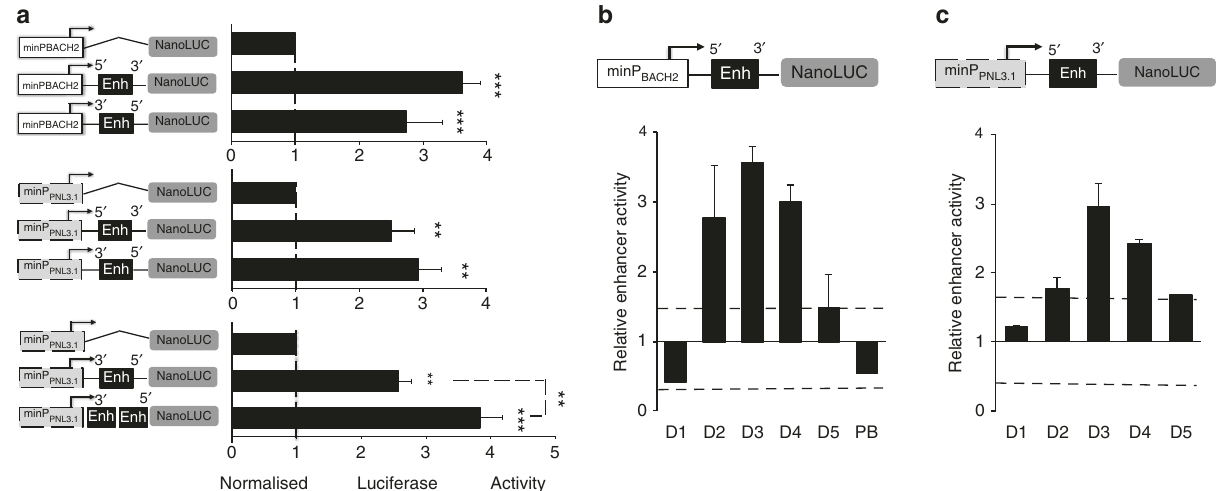
Fig. 8 Enhancer activity of the 228 bp intronic sequence encompassing the ELK1 binding site. a Luciferase activity of primary activated naive B cells transfected with luciferase reporter plasmids for intron 1 enhancer (Enh) sequence (position +1265; +1493) ligated in either 5 ′ -3 ′ or 3 ′ -5 ′ orientations, made in conjunction with the proximal BACH2 promoter (minP BACH2 , position − 725; +146) or with the independent pNL3.1 minimal promoter (minP PNL3.1 ). Luciferase activity measured at D3, 24 h after electroporation, is presented relative to the promoter activity alone fi xed to 1 (line1). Data are representative of three independent experiments (means ± s.e.m., ** p < 0.01 *** p < 0.005, two-tailed unpaired Student ’ s t -test). b Temporal dynamic of the enhancer activity across naive B cells activation and differentiation assessed from D1 to D6 in sorted plasmablasts (PB). Activated B cells were electroporated with the reporter constructs carrying the enhancer sequence in conjunction with the BACH2 promoter b or an independent minimal promoter c . Luciferase activity was measured 24 h later. Enhancer activity is presented relative to promoter activity alone arbitrary fi xed to 1. Data are means ± s.e.m. from 6 (in b ) and 3 (in c ) independent experiments. Statistically signi fi cant cutoff values (dotted lines) were obtained by adding two standard deviations to